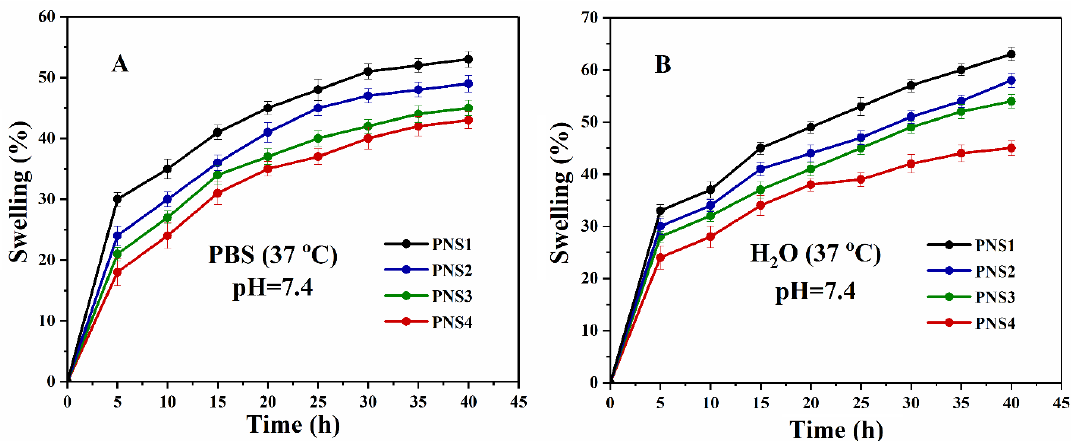
Figure 6. Swelling behavior of scaffolds in phosphate buffer saline (PBS) ( A ) and water ( B ) keeping temperature at 37 °C and 7.4 pH.